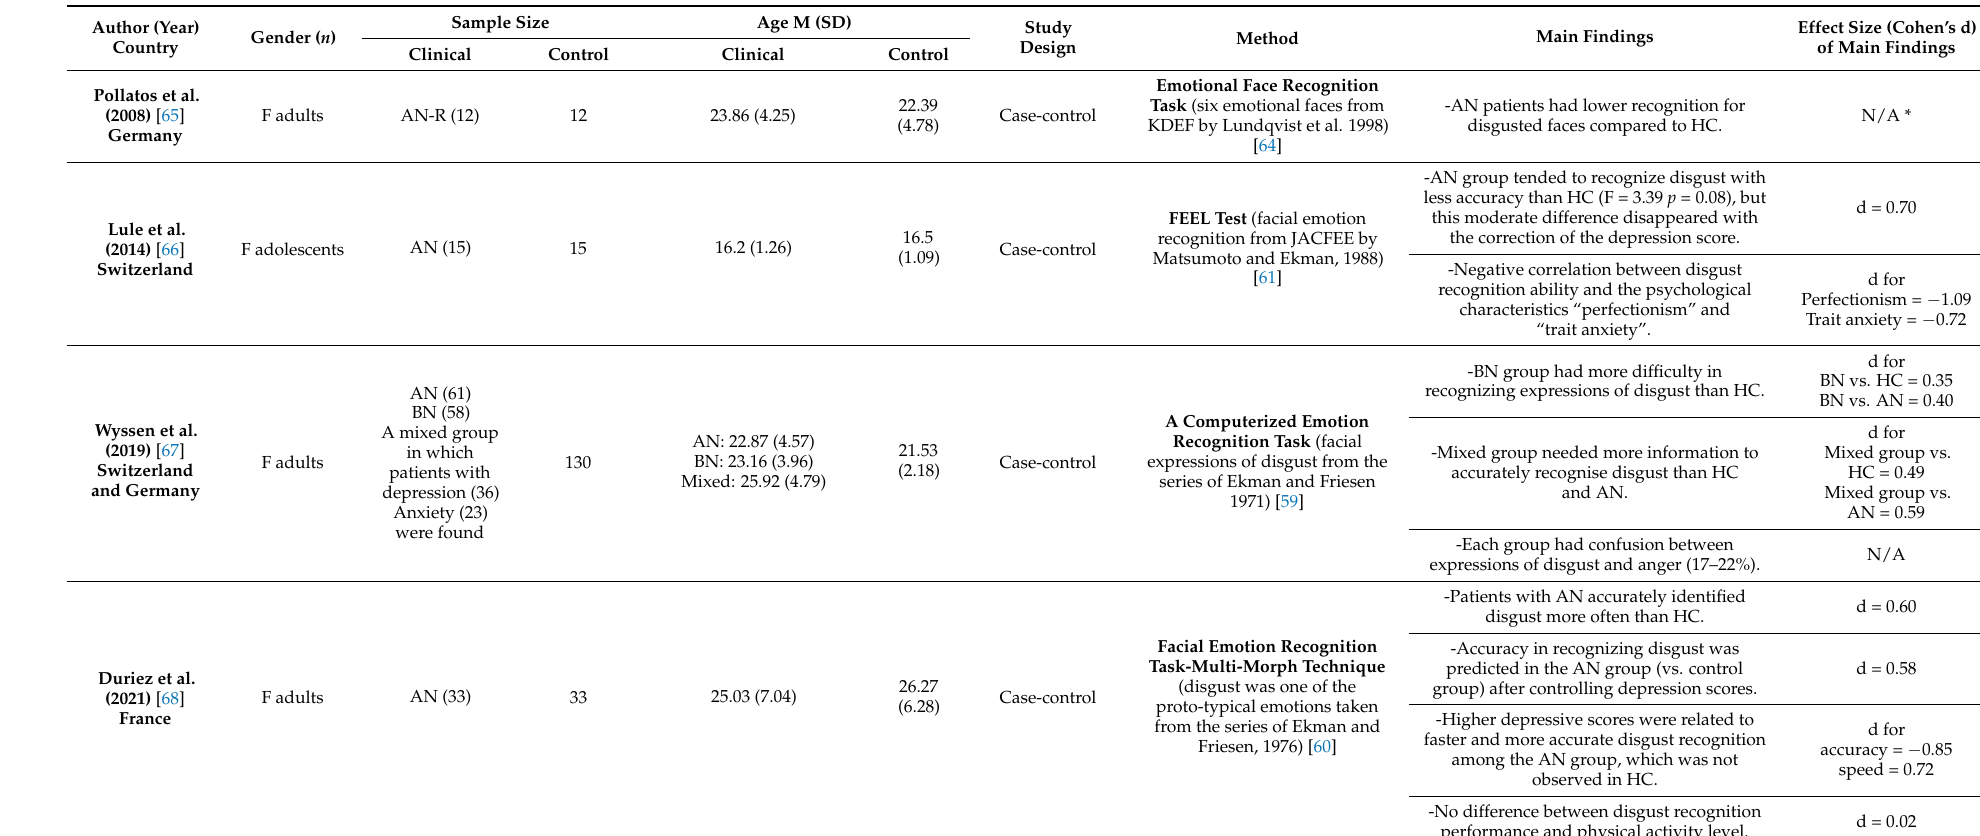
Table 3. A summary of studies using experimental tasks to measure cognitive–emotional aspects of